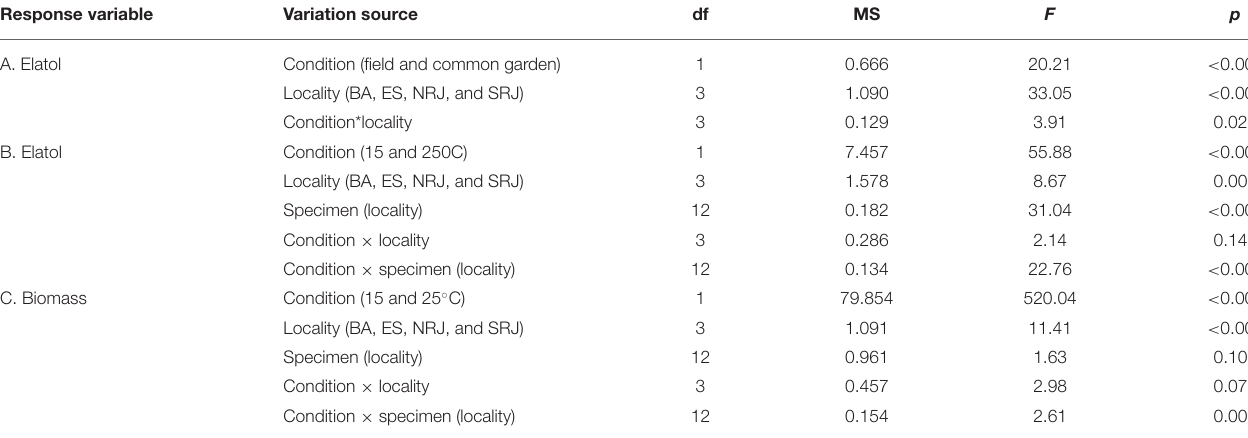
TABLE 1 | ANOVA results were performed on data from experiments examining phenotypic responses of Laurencia dendroidea ( = elatol production and biomass). Response